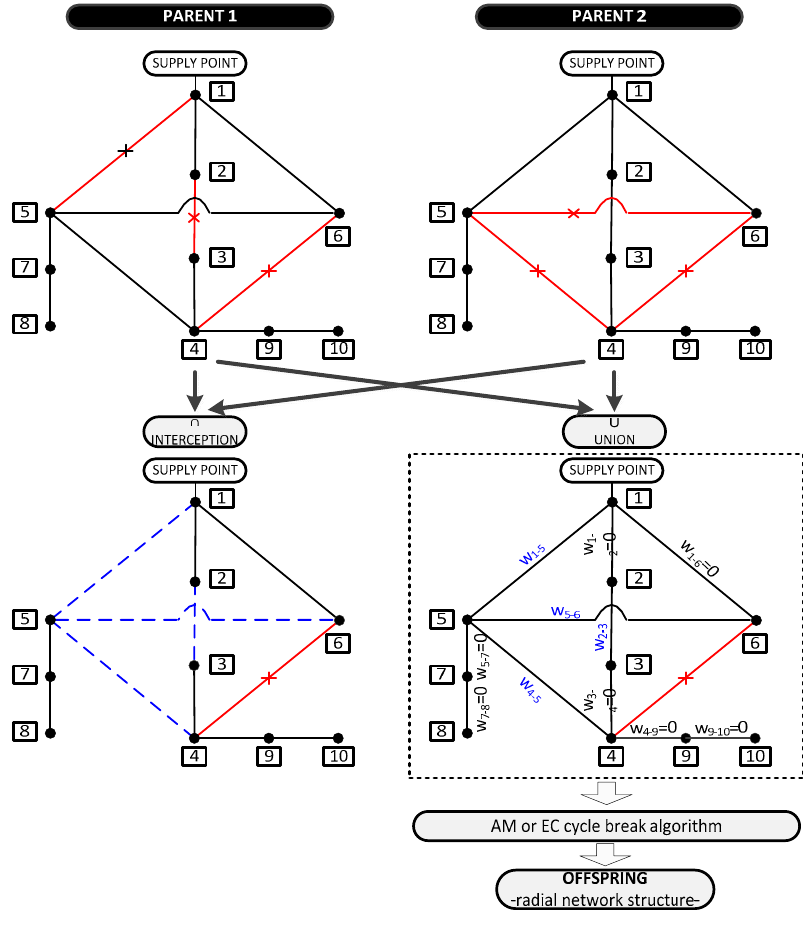
Figure 5. Illustration of crossover process.